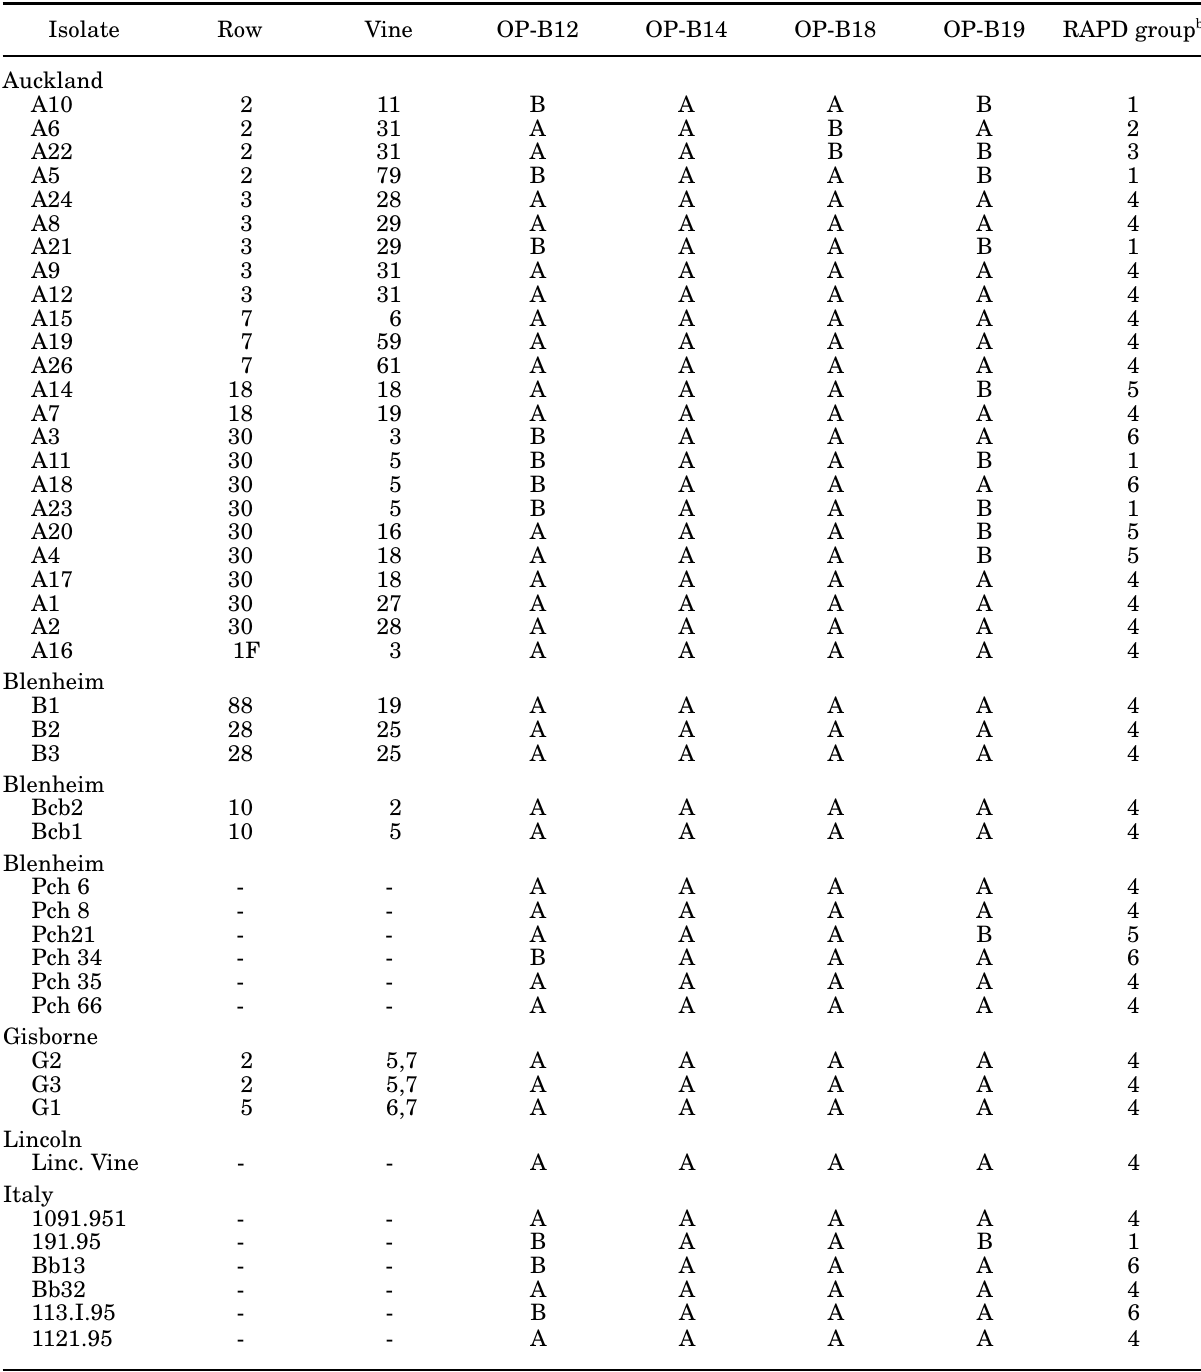
Table 4. Combined results from RAPD analysis indicating inter-vineyard, intra-vineyard and intra-vine variation between New Zealand and Italian isolates of Phaeomoniella chlamydospora a . Isolate Row Vine OP-B12 OP-B14 OP-B18 OP-B19 RAPD group